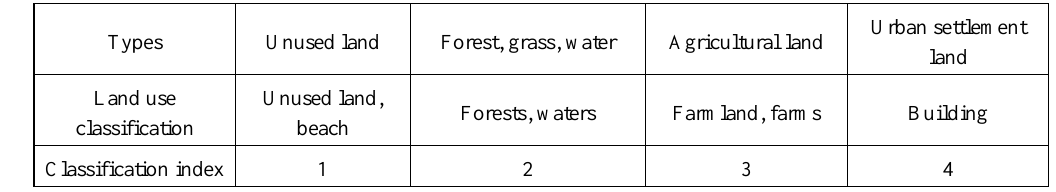
Table 2 Land use type intensity grading index